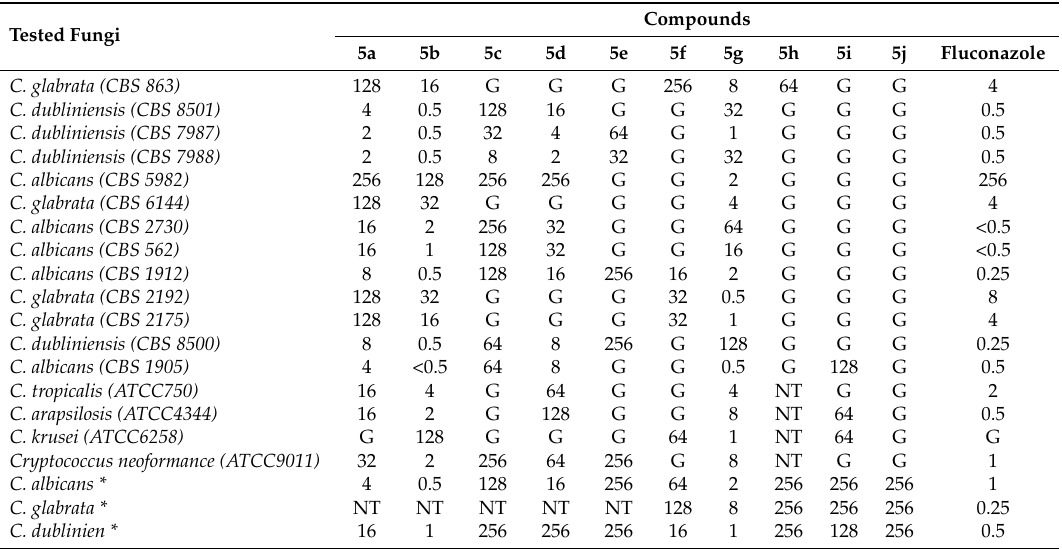
Table 1. Antifungal activities of 5a – 5j against Yeasts (MICs, µ g/mL). Tested Fungi